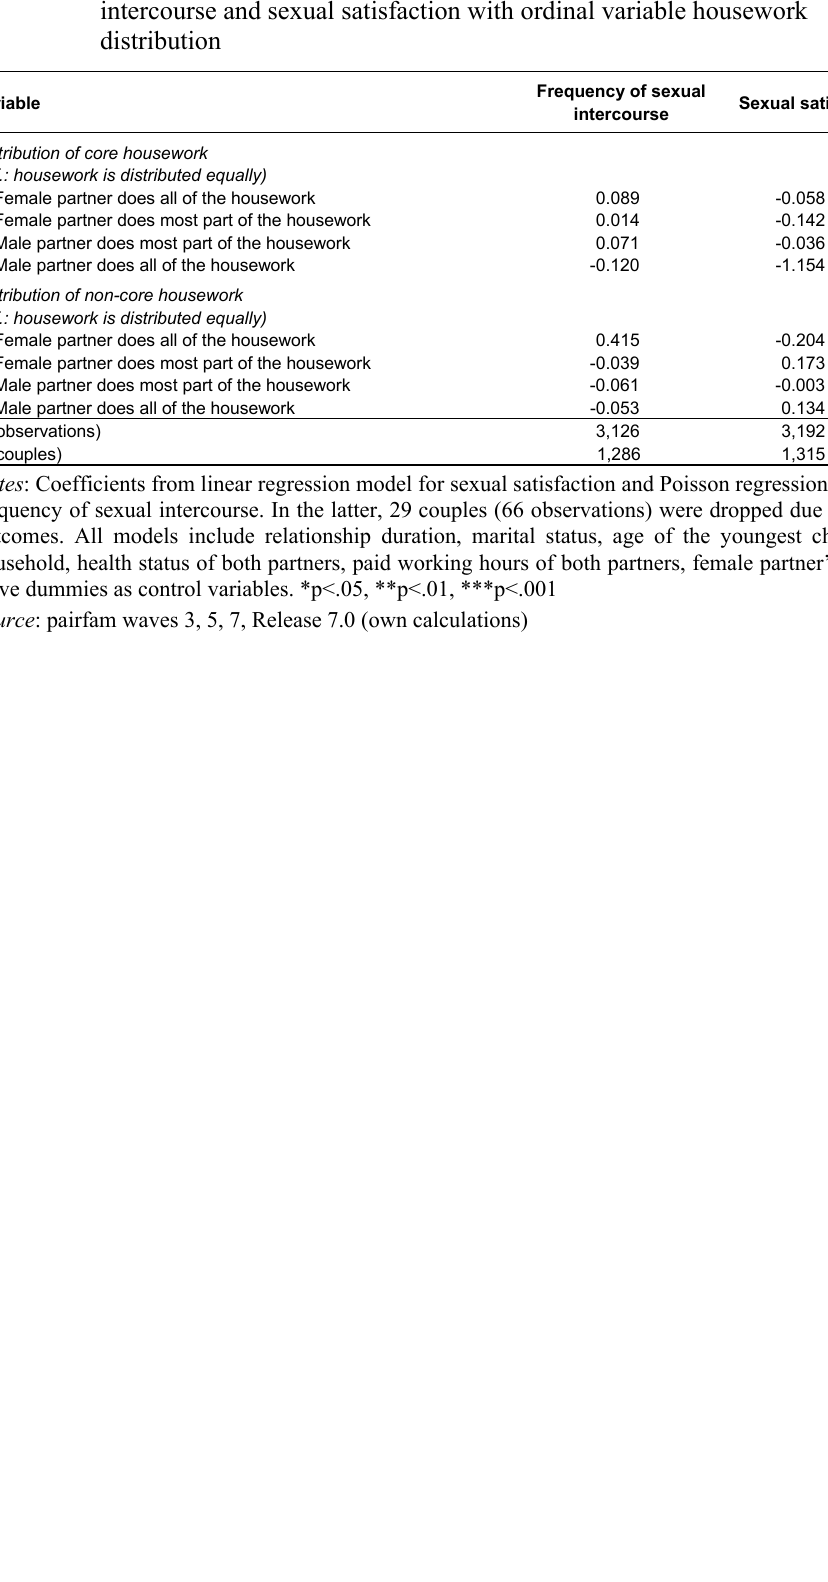
Table A.4 : Summary of fixed effects regression analyses estimating frequency of sexual intercourse and sexual satisfaction with ordinal variable